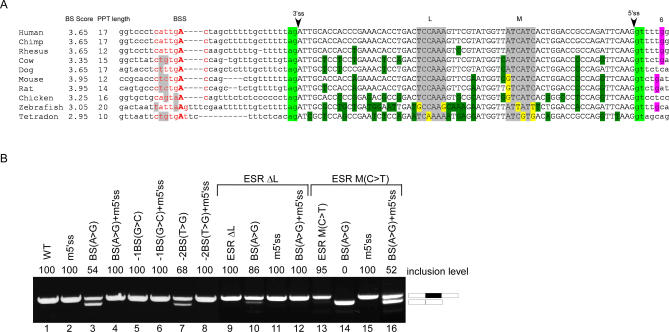
The Effects of ESRs on Constitutive and Alternative Splicing(A) Alignment of exon 12 of the IMP gene among 10 different organisms. The BS score and the PPT length are indicated on the left. The putative BS is in red, with the branch-point A in uppercase. BS sites that differ from the human sequence are highlighted in gray, with the mutated nucleotides in bold. The AG and GT of the 3′ and 5′ss are highlighted in green. The examined ESR sites L and M are highlighted in gray, ESR L was deleted and ESR M was disrupted by a C to T mutation. The shift of the G from position 5 to 6 in the 5′ss is highlighted in purple. Nucleotides that are highlighted in yellow and green show exonic positions that were changed during evolution (with respect to the human sequence) inside the five ESRs and outside of those sites, respectively. Upper and lower case indicate exonic and intronic sequence, respectively. (B) WT and mutant plasmids were introduced into 293T cells by transfection. Total RNA was extracted and splicing products were separated on a 2% agarose gel after RT-PCR analysis. Lane 1, splicing of the WT IMP minigene. Lanes 2 through 16, splicing products of the indicated mutants. The following abbreviations are used: m5′ss indicates mutations that reconstitute the human 5′ss to that of mouse, 1BS(G>C) indicates mutation at position −1 relative to the branch-point nucleotide from G to C, ESR ΔL and ESR M(C>T) indicate deletion of ESR L and a point mutation from C to T in ESR M, respectively. Numbers on top indicate percentage of exon inclusion as determined by ImageJ analysis. The two minigene mRNA products are shown on the right.